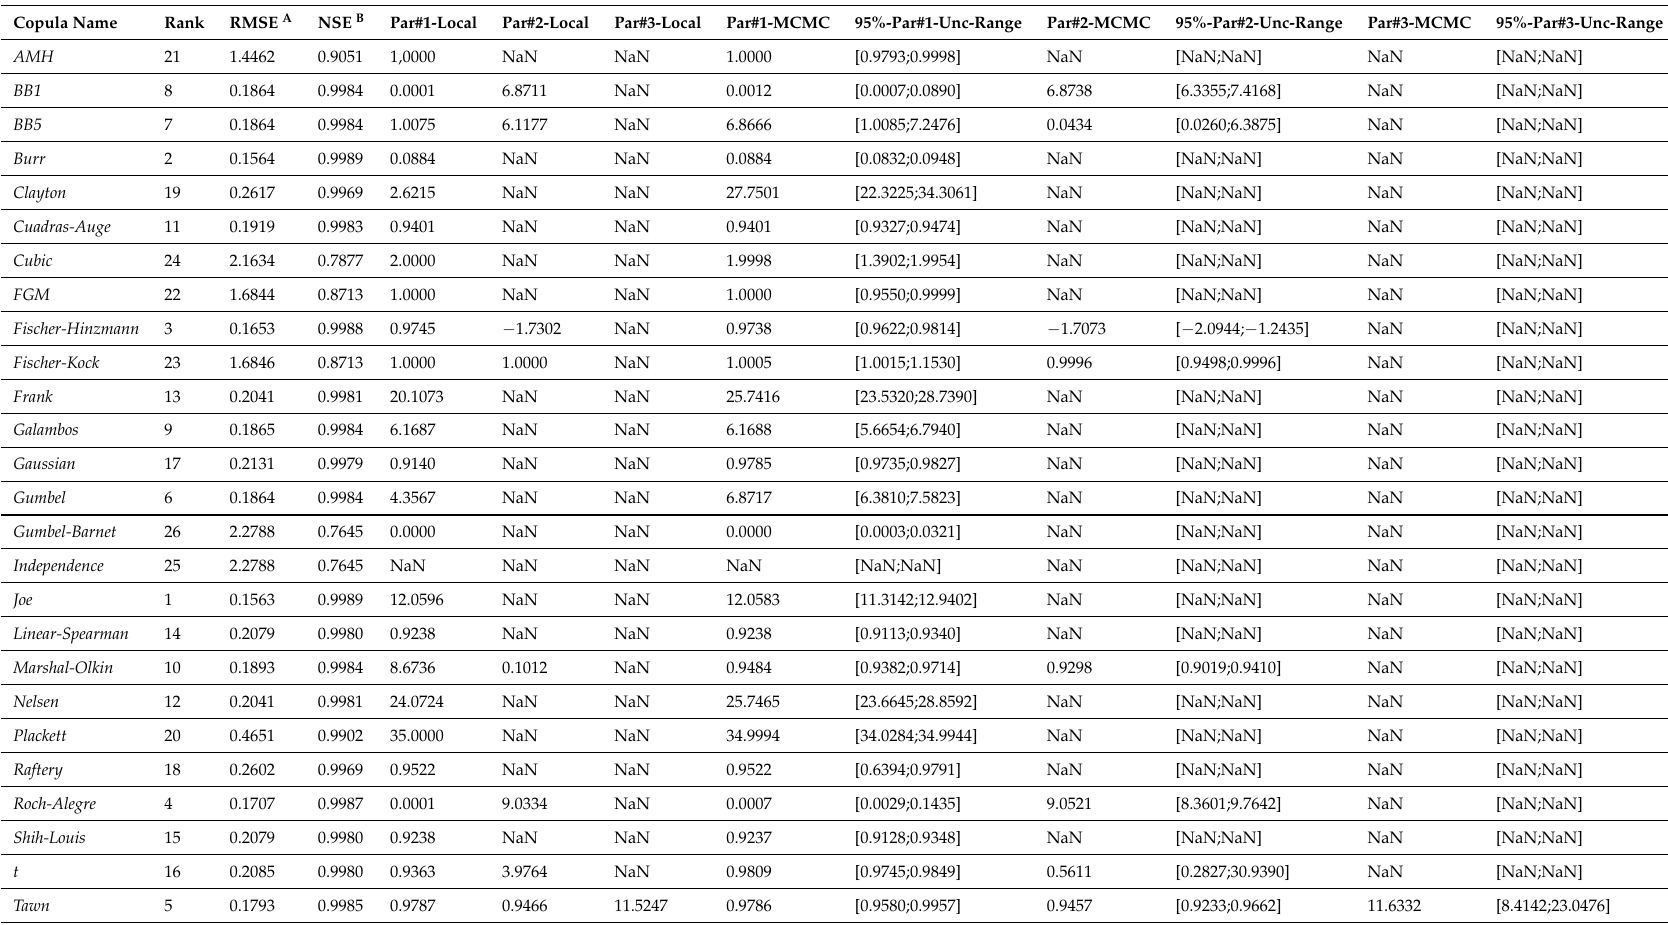
Table 5. Copula parameters estimation: DJIA